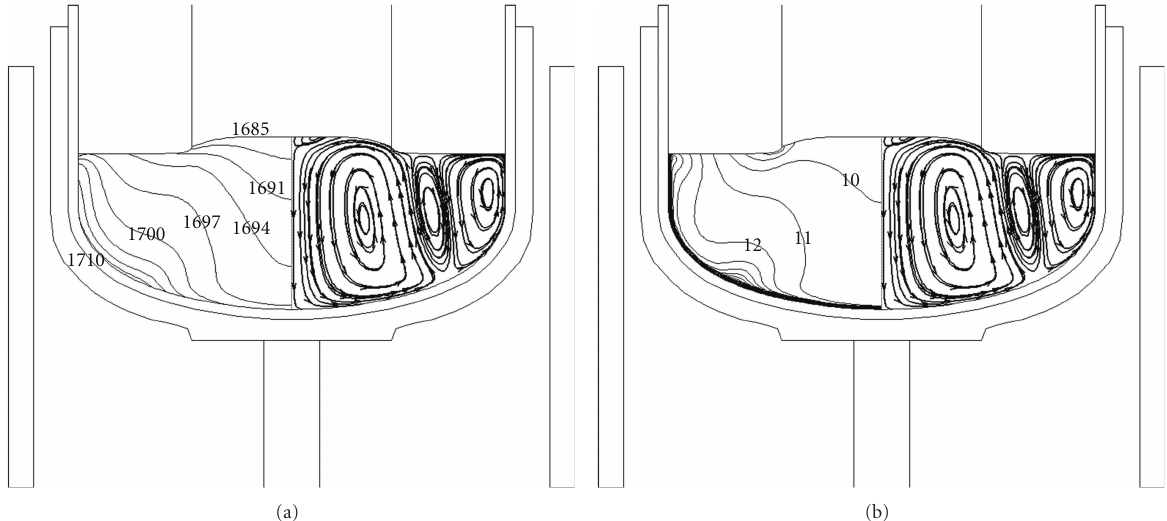
Figure 5: Distribution of temperature, streamtrace, and oxygen concentration in the melt for L = 300 mm in a conventional CZ furnace ( h = 0mm): (a) isothermal lines (left) and streamtraces (right); (b) oxygen concentration isolines (left) and streamtraces (right). The units of temperature, velocity vector, and oxygen concentration are K, m/s, and ppma, respectively. The spacing of the isothermal lines and concentration isolines are 3 K and 1ppma, respectively.